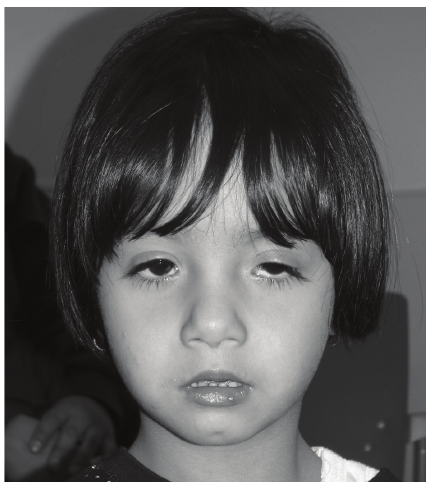
Figure 1: Patient at age of 2 years, 11 months. Used with permis- sion.